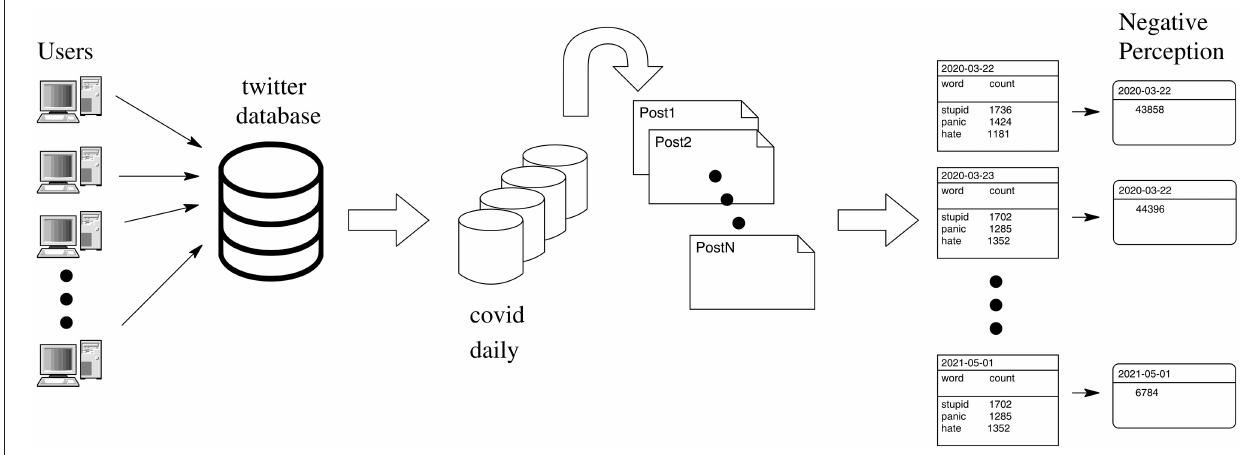
FIGURE 1 | Flow of the Twitter data processing. Users feed the Twitter database with pieces of text (i.e., posts), and an algorithm extracts from this database only the posts related to the COVID-19 pandemic (e.g., Banda et al., 2021). The COVID-related posts are then processed on a daily basis to generate tables containing the negative words and the number of their ocurrences. The negative perception represents the sum of all ocurrences taken daily from these tables.